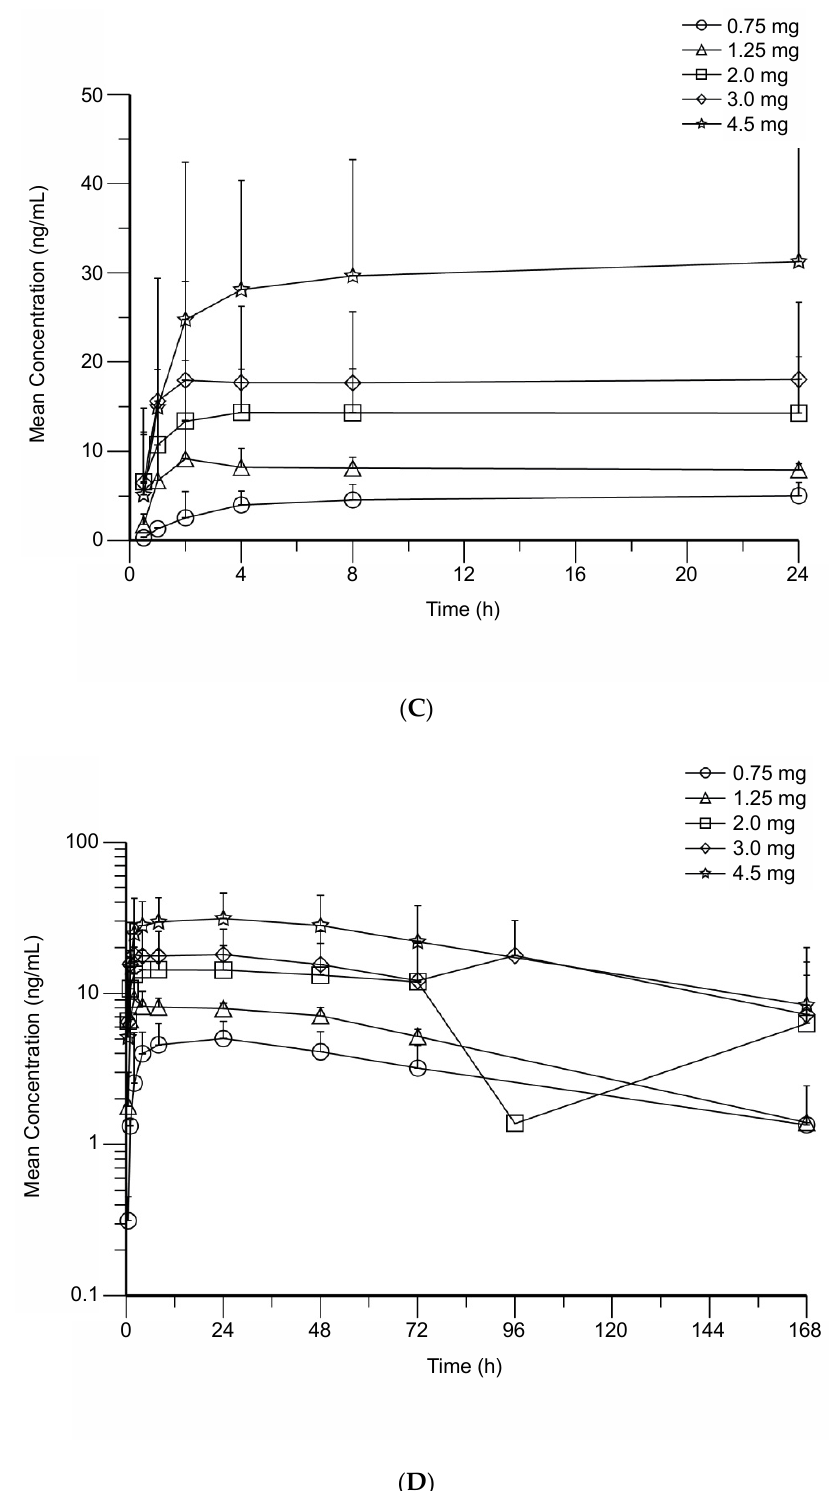
Figure 1. Mean plasma concentration, following a single dose of BMS-986158, of ( A ) BMS-986158 through 24 h; ( B ) BMS-986158 through 168 h; ( C ) a metabolite of BMS-986158 through 24 h; and ( D ) the metabolite through 168 h.